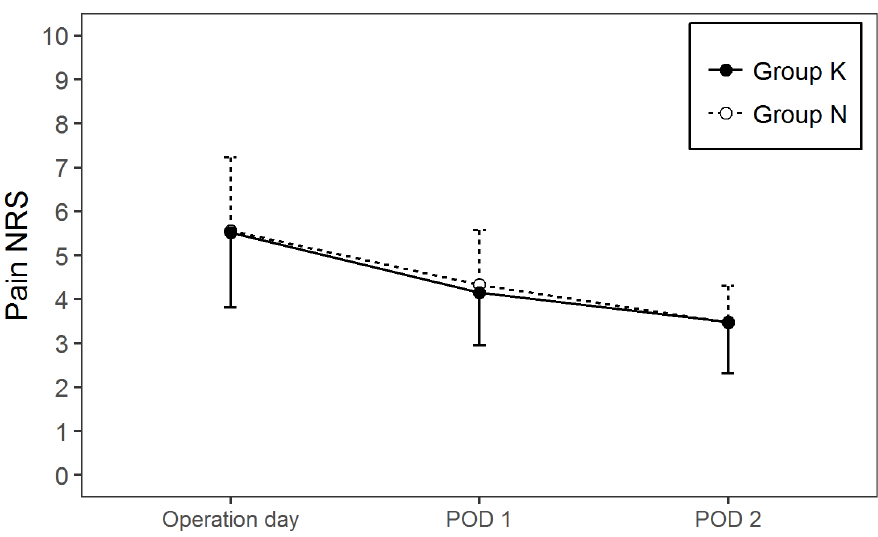
Fig 1. Numeric rating scale pain score assessed at different times during the 3-day postoperative follow-up period. Data are expressed as mean (SD). NRS, numeric rating scale; Group N, nefopam group; Group K, ketorolac group; POD 1, postoperative day 1; POD 2, postoperative day 2.